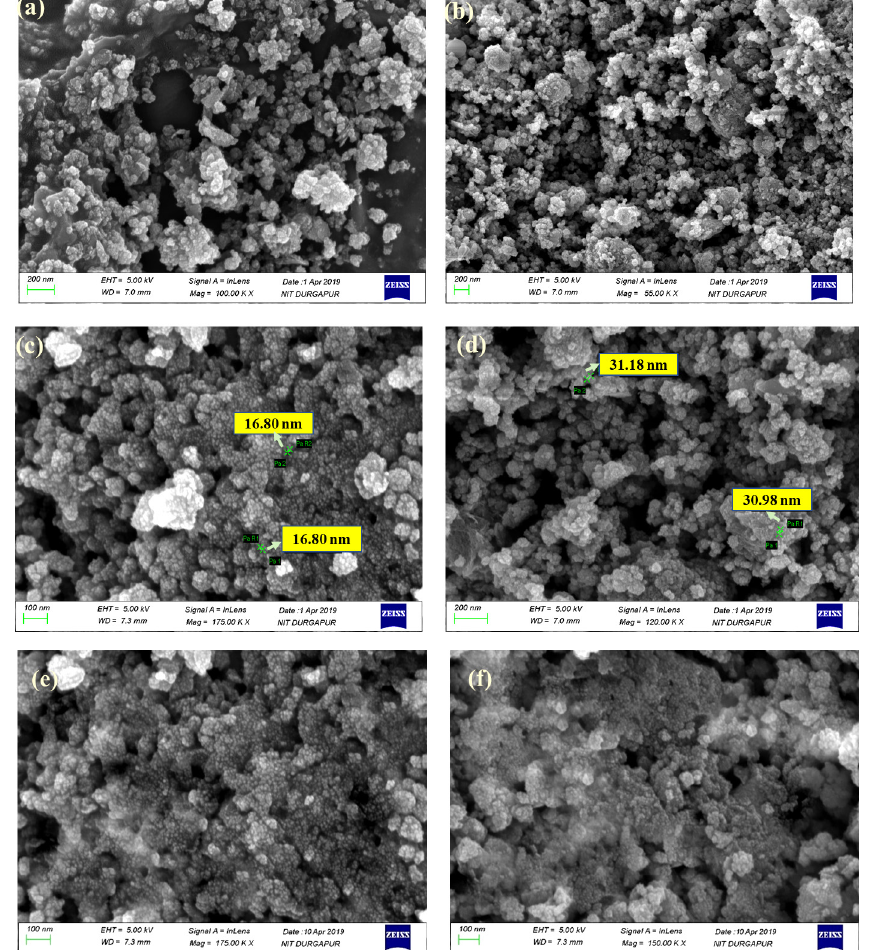
Figure 3. FE-SEM image of iron oxide (Fe 3 O 4 ) NP’s at different magnification scale (a), (b), (c) and (d) before adsorption, (e) and (f) after